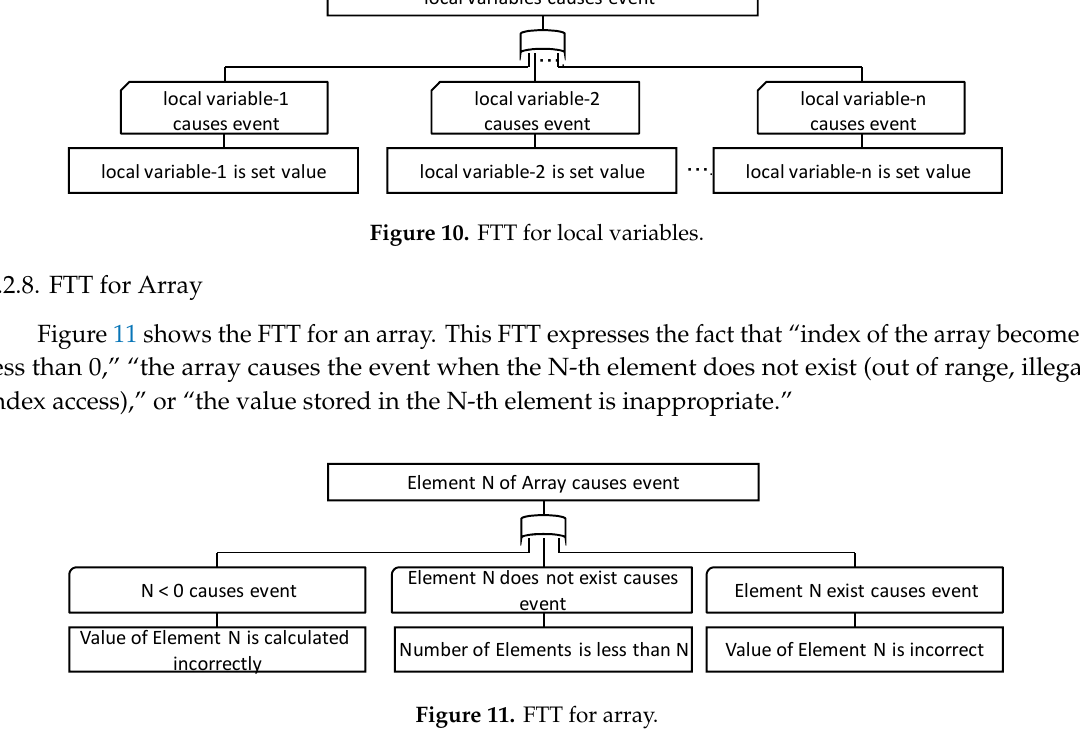
Figure 12. FTT for pointer. 3.2.10. FTT for Hierarchical Instruction Here, we shall discuss an FTT when an instruction is hierarchically combined. Hereinafter, we refer to this kind of instruction as a hierarchical instruction. For example, an instruction where a tracked instruction exists within a controlled instruction, such as a block if instruction or while instruction, etc., is a hierarchical instruction. In this case, the controlled instruction including the tracked instruction is seen as one instruction, and to express that targeted instruction is executed when the conditions in the controlled instruction are established, FFTs are combined in the order of controlled instruction to targeted instruction. If the hierarchical instruction has three or more layers, the hierarchical instruction is seen as being within the scope of the furthest external instruction, and it connects the FTT from the furthest external instruction to the nearest internal instruction. At this time, the layer number for the furthest external layer is referred to as L max , and the nearest internal hierarchical instruction is set to “1.” The method of developing the FT for the hierarchical instruction is explained later under FT development rules in Section 3.3. 3.3. FT Development Rules In this subsection, we discuss static program slicing (hereinafter, slicing) used to determine instructions executed just before the instruction being executed. Next, we discuss the ECSW information required for executing FTA. Third, we discuss FT development rules. Finally, we discuss FTA support tools. 3.3.1. Slicing Slicing is a method of extracting all instructions that impact the calculation results for the variables focused on in the program, and the extracted instruction groups are called slices [24]. When the same input is applied to the original program and the slice, the calculation results for the variable